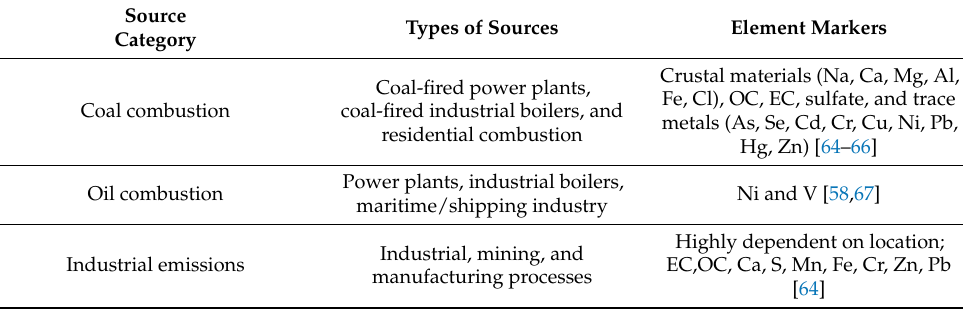
Table 3. Summary of PM source categories and their respective elemental